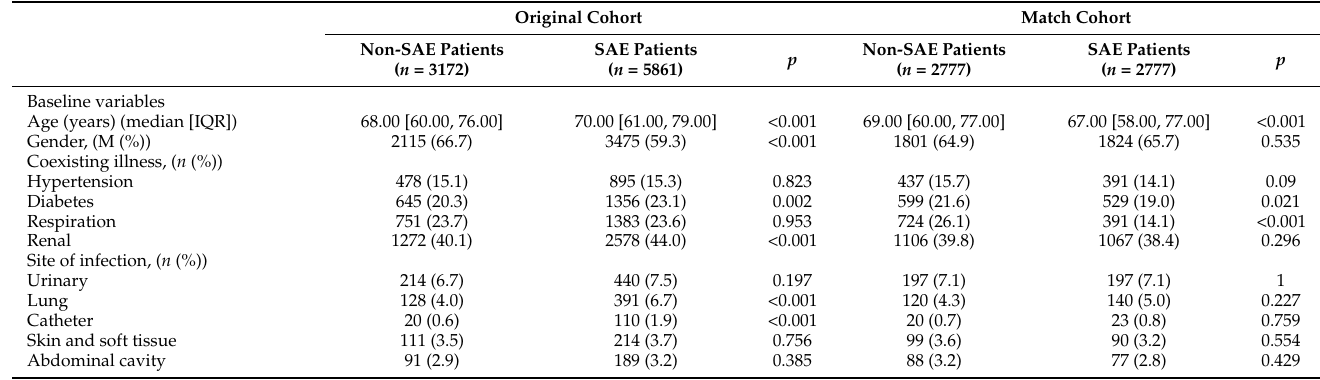
Figure 1. Flow chart for patient selection. SAE: sepsis-associated encephalopathy. Table 1. Baseline characteristics and outcomes of patients with sepsis. Original